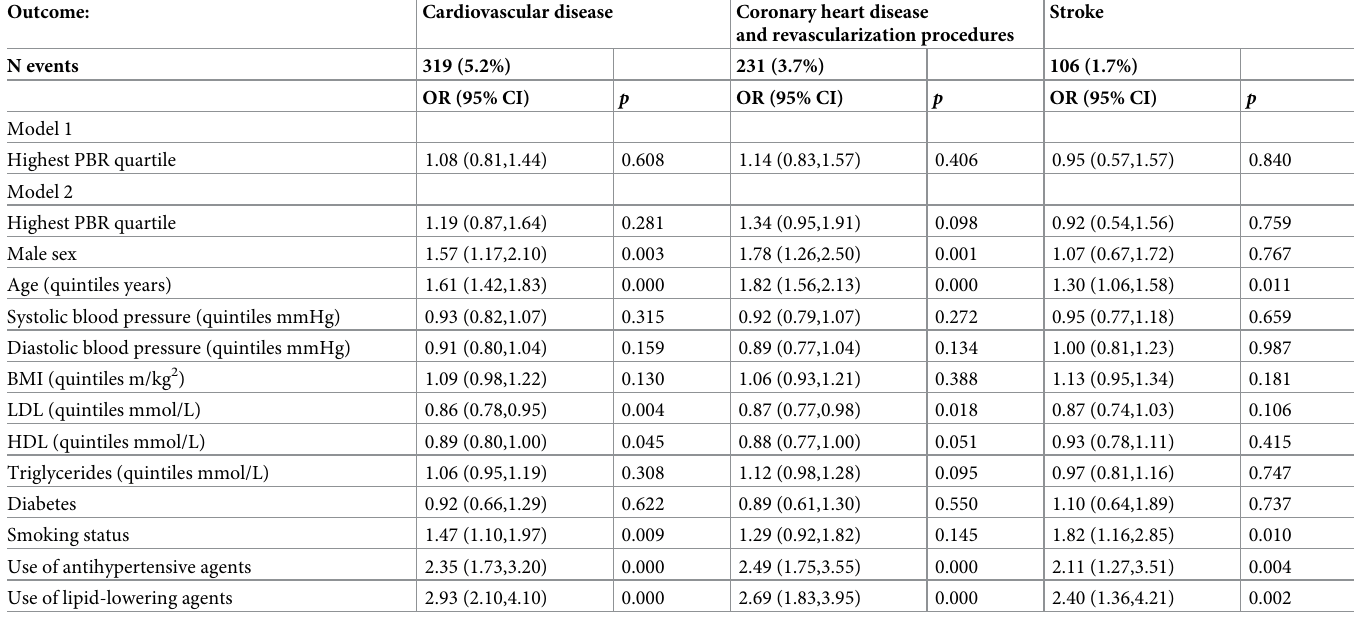
Table 3. Univariate and multivariate logistic regression analysis of the association between highest PBR (smallest glycocalyx size) and cardiovascular disease outcomes. Outcome: Cardiovascular disease Coronary heart disease